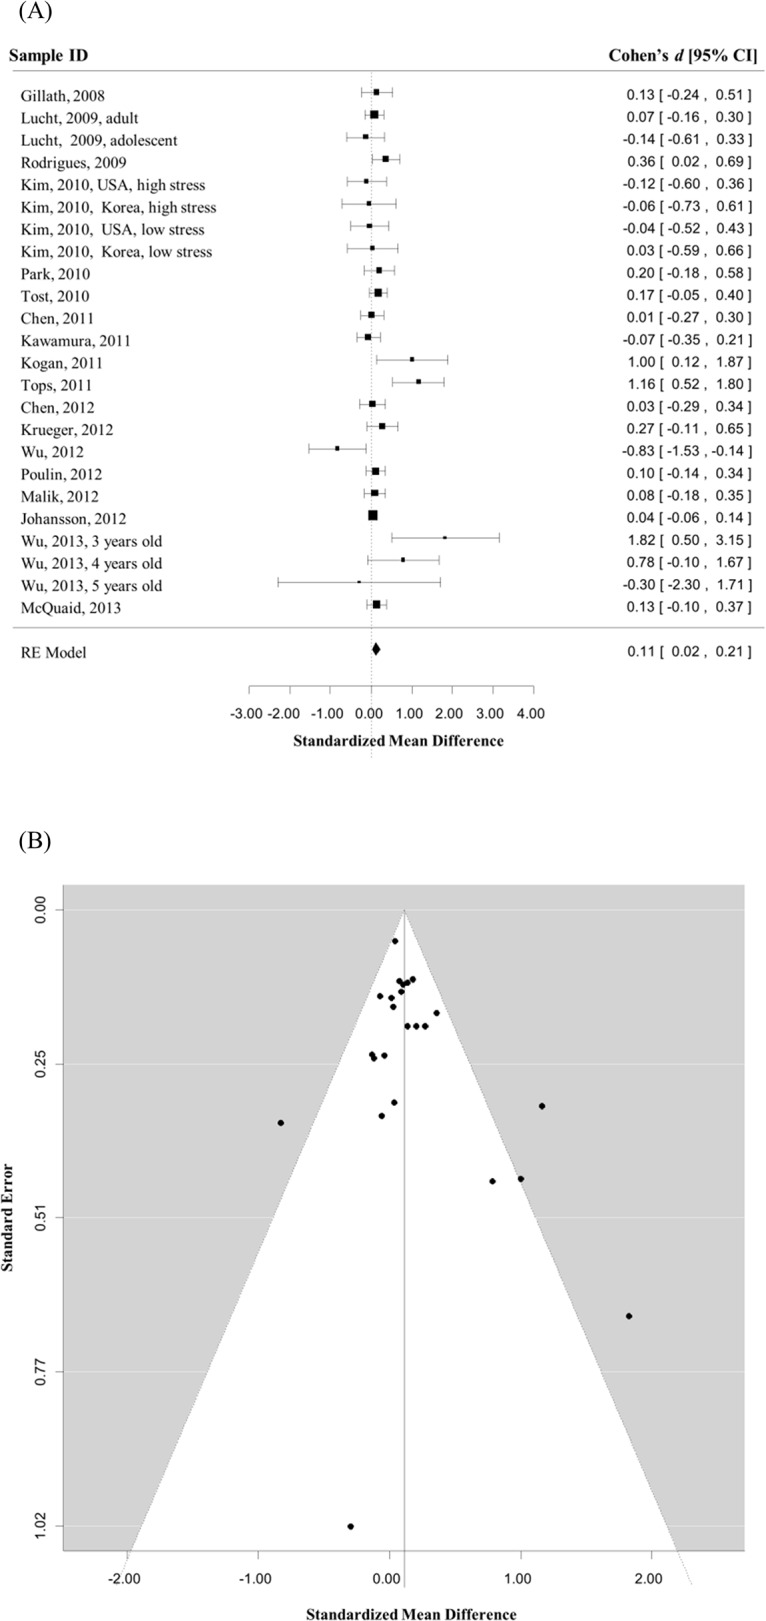
The association between rs53576 polymorphism and general sociality.A) Magnitudes of effect size for the association between rs53576 polymorphism and general sociality are illustrated by the forest plot (AA + GA vs. GG). Boxes represent the effect size (Cohen’s d) for each sample in the analysis; the size of the boxes represents the weighting for each study; lines represent the .95 confidence interval for each effect size; and the diamond represents the overall effect of the meta-analysis, which was obtained by a random effects model. B) Publication bias is illustrated by the funnel plot. The horizontal axis represents the effect size of each study. The vertical axis represents the size of each study (indexed by the standard error of the effect size within each study). In consequence, large studies appear towards the top of the graph and small studies appear towards the bottom of the graph. A vertical line indicates the estimated overall effect size. A confidence interval region is drawn around this value with bounds equal to ± 1.96 standard error. In the absence of publication bias, the studies will be distributed symmetrically around the vertical line. Otherwise, the studies will be distributed asymmetrically.